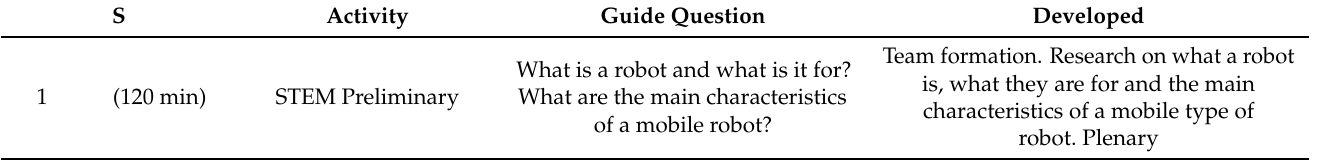
Table 1 describes the planning of the sessions developed during the unit. Table 1. Session plan. S indicates the session